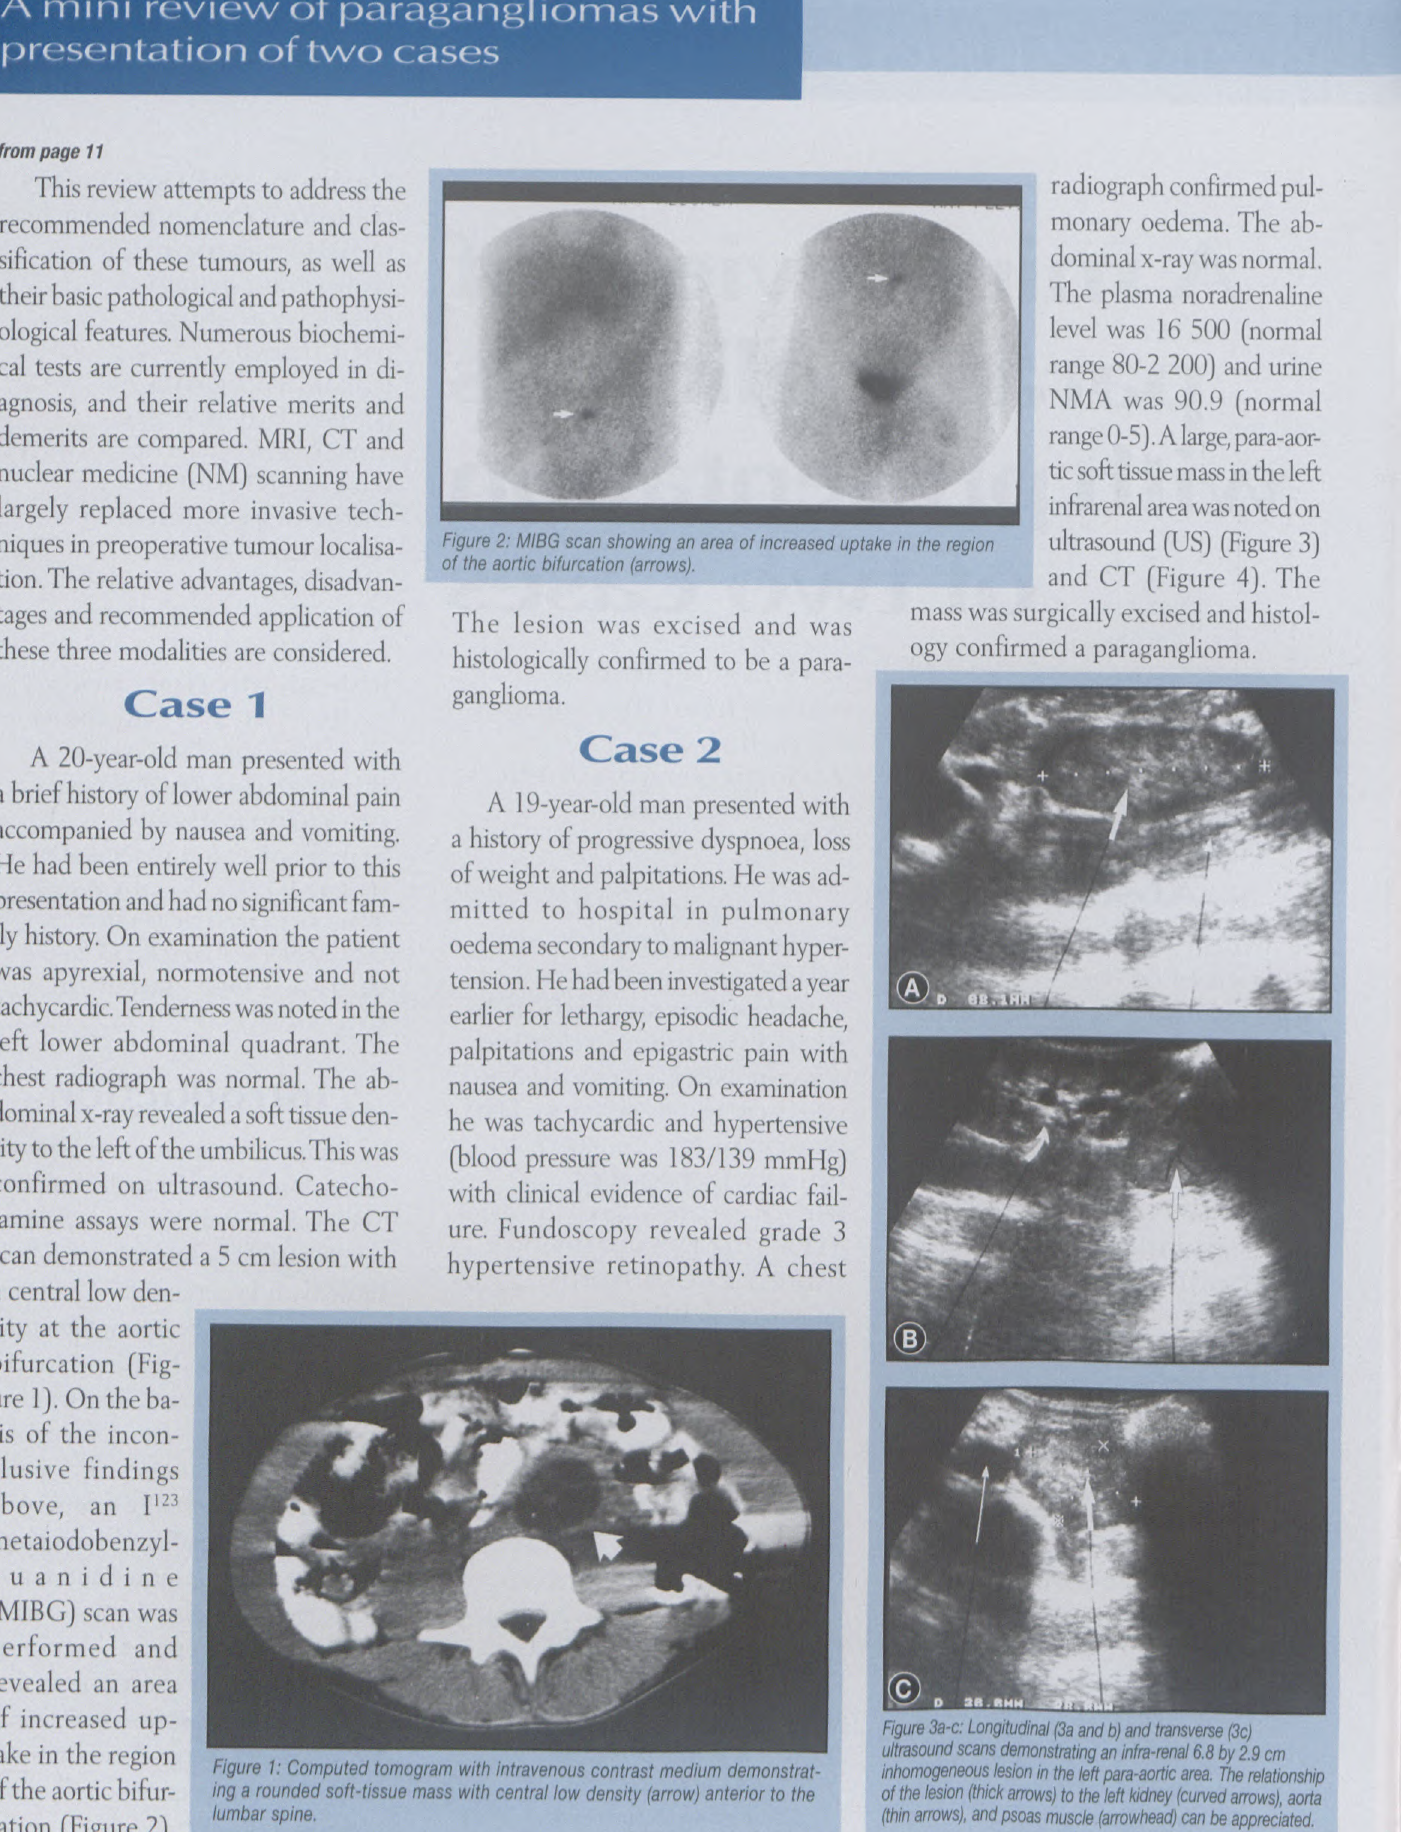
Figure3a-c: Longitudinal (3aand b) and transverse (3c) ultrasound scans demonstratingan infra-renaI6.S by 2.9 cm inhomogeneouslesionin the left para-aortic area. Therelationship of the lesion (thickarrows)to the left kidney(curvedarrows),aorta (thinarrows),and psoas muscle (arrowhead)canbe appreciated. to page